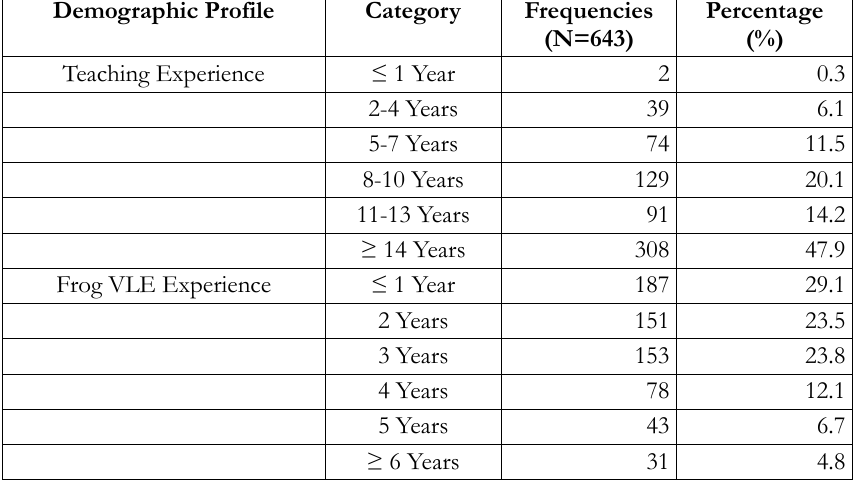
Table 3. Analysis of Respondent’s